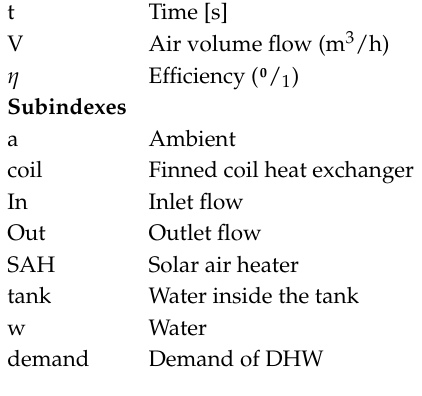
Table 2. Experimental results of the SAHs.